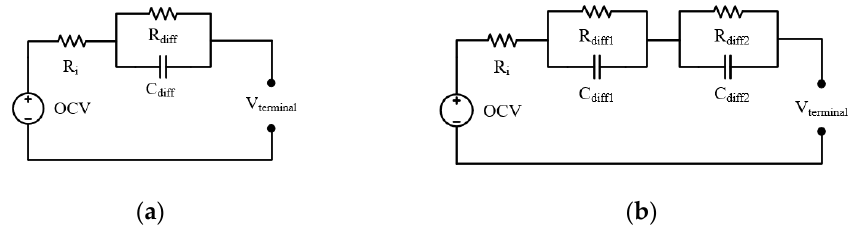
Figure 2. Battery equivalent circuit model (ECM): ( a ) 1-RC ECM, ( b ) 2-RC ECM.